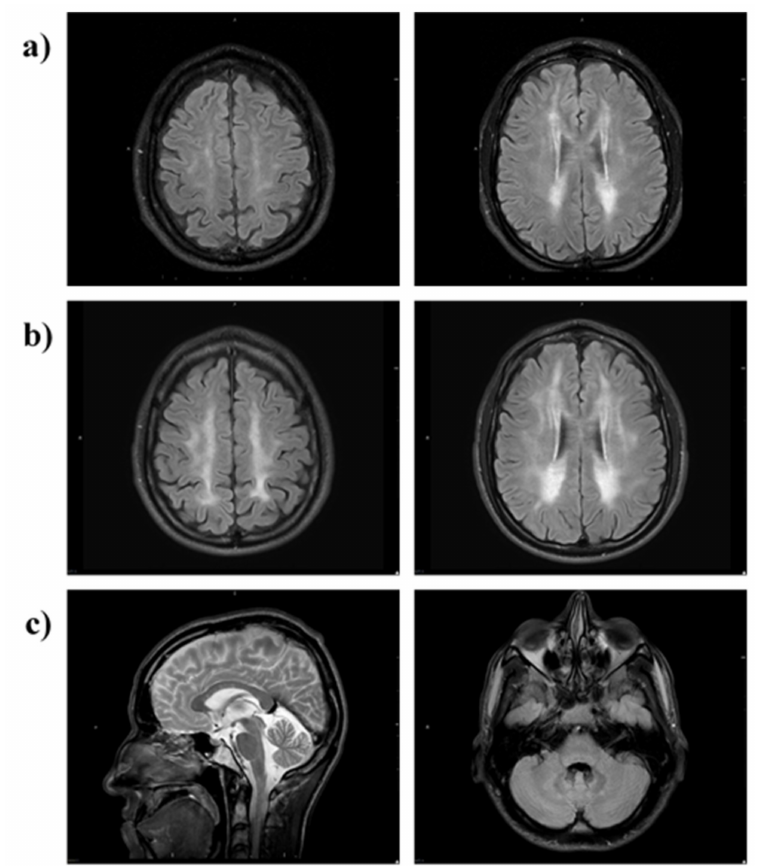
Figure 7. MRI brain of Patient 2. MRI (axial FLAIR) at ( a ) 28 months and ( b ) 63 months shows progression of T2/FLAIR hyperintense cerebral white matter changes (leukoencephalopathy). The scan at 28 months shows patchy involvement of cerebral periventricular, deep and subcortical white matter ( a ) which 35 months later is more confluent and extensive ( b ). There is relative sparing of the U-fibres and the corpus callosum ( c , left image) and infratentorially there is minor symmetrical FLAIR hyperintensity in the cerebellar peridentate white matter ( c , right